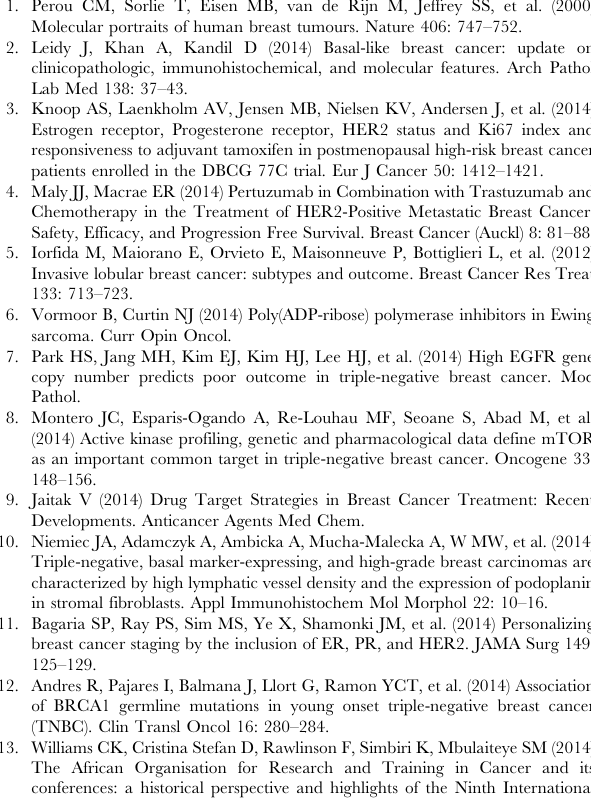
Figure S1 Distribution of miR-10b, miR-21 and miR- 182 according to lymph node metastases status in triple negative and non triple negative breast cancer. Figure S2 Roc curve of the lymph node metastases occurrence prediction according to miR-10b, miR-21, miR-148a and miR-182 fold expression among triple negative breast cancer cases. Figure S3 Roc curve of the high grade (III) occurrence prediction according to miR-10b fold expression among non triple negative breast cancer